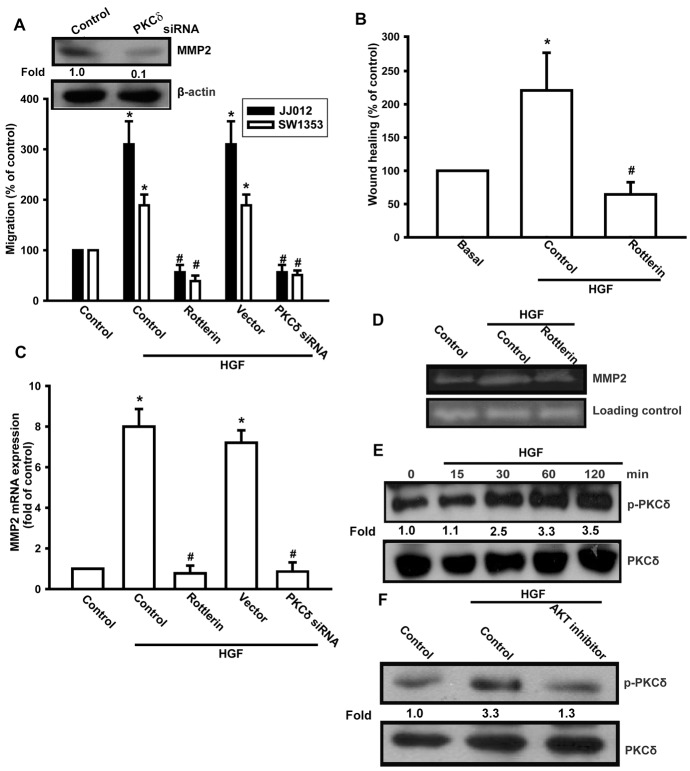
The PKCδ pathway is involved in HGF-mediated migration in human chondrosarcoma cells.(A–D) Cells were pretreated for 30 min with rottlerin (3 µM) or transfected with PKCδ siRNA 24 h, followed by stimulation with HGF; cell migration and MMP-2 expression were then examined by Transwell, wound healing, qPCR, and zymography assays. (E) JJ012 cells were incubated with HGF for the indicated time intervals, and p-PKCδ expression was determined by western blotting. (F) JJ012 cells were pretreated for 30 min with Akt inhibitor, followed by treatment with HGF for 30 min; p-PKCδ expression was examined by western blotting. Results are expressed as mean ± S.E. *p<0.05 compared with control; #p<0.05 compared with HGF-treated group.